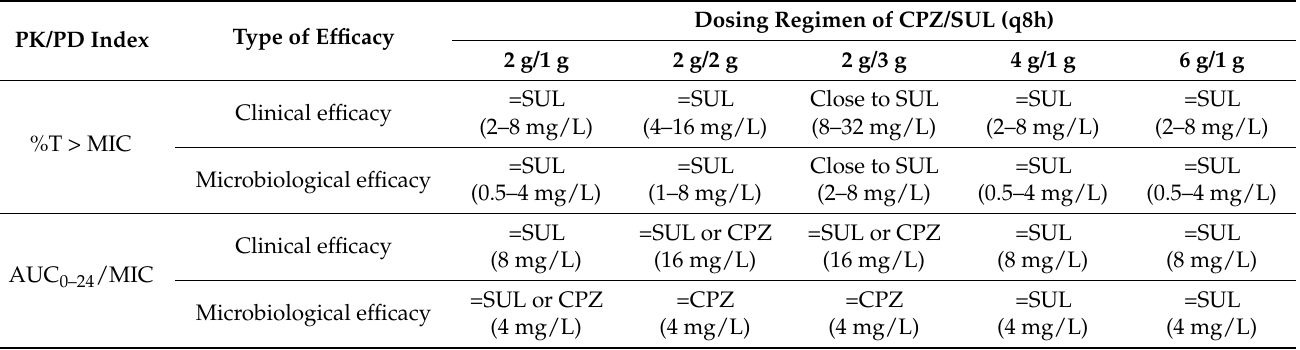
Table 8. Comparison of PK/PD cutoff obtained from combined PTA or single